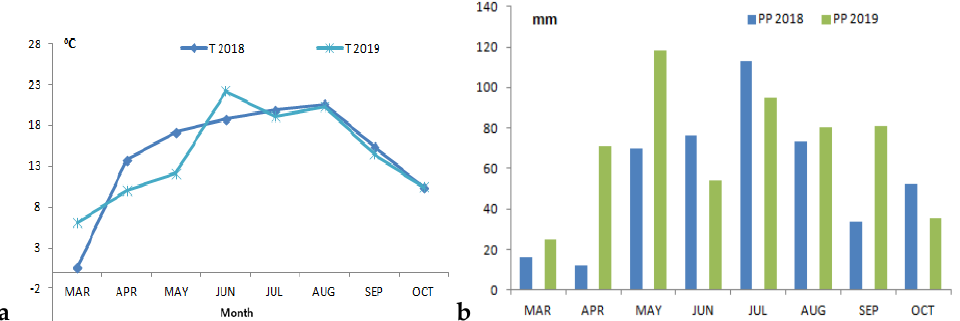
Figure 1. Average monthly temperature ( a ) and amount of precipitation ( b ) in the growing seasons 2018 –